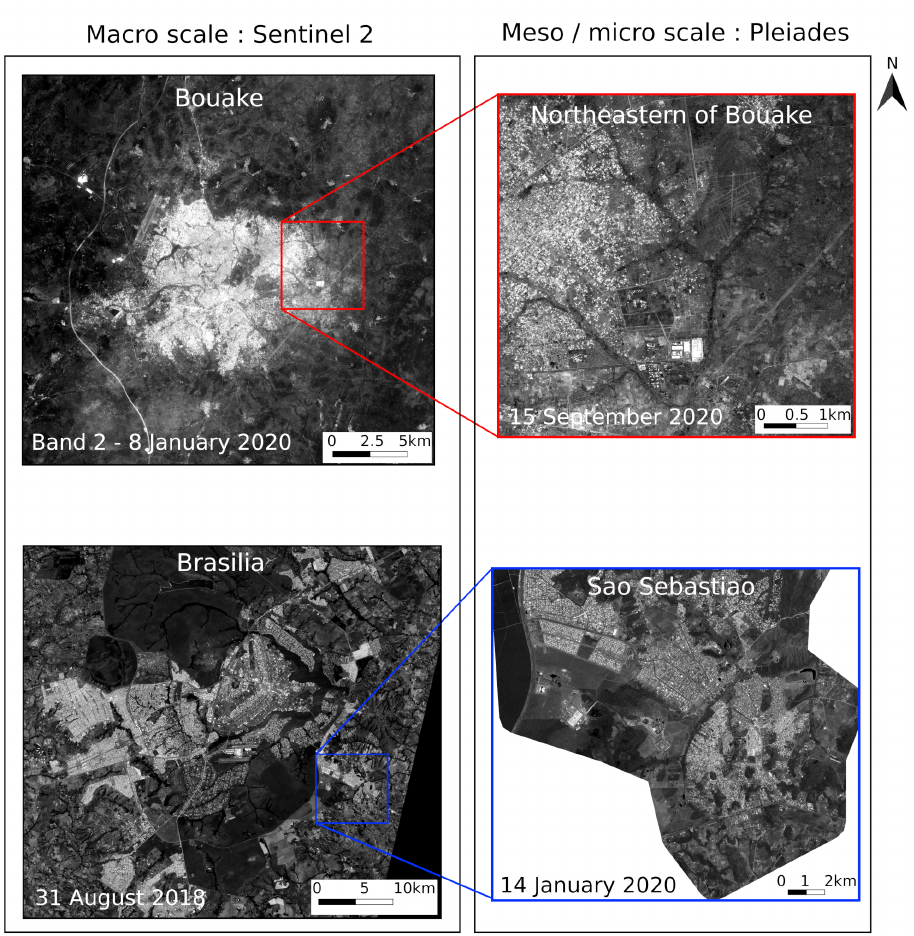
Figure 1. Study areas and satellite imagery used in this study. On the left, band 2 (blue) of Sentinel 2 images on Bouake ( top ) and Brasilia ( bottom ) are shown (Copernicus Sentinel data (2018-2020)/ESA). On the right Pleiades images (panchromatic channel) on the northeastern part of Bouake and Sao Sebastiao, a satellite City of Brasilia (Contains information © CNES 2020, Distribution Airbus DS, all rights reserved. No commercial